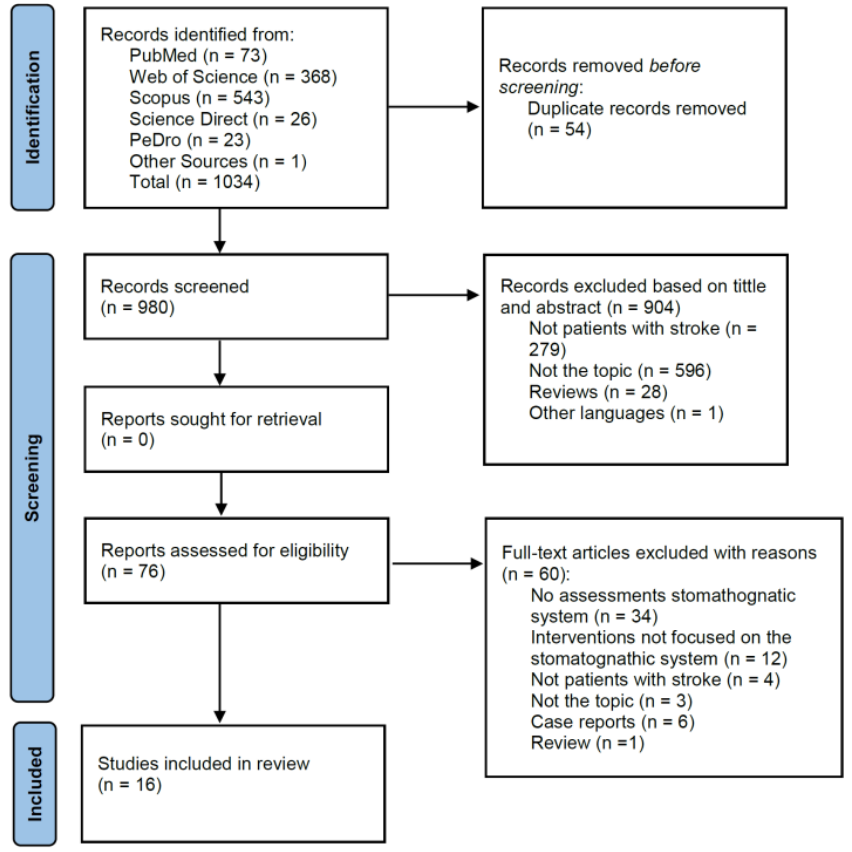
Figure 1. Flow Figure 1. Flow chart.